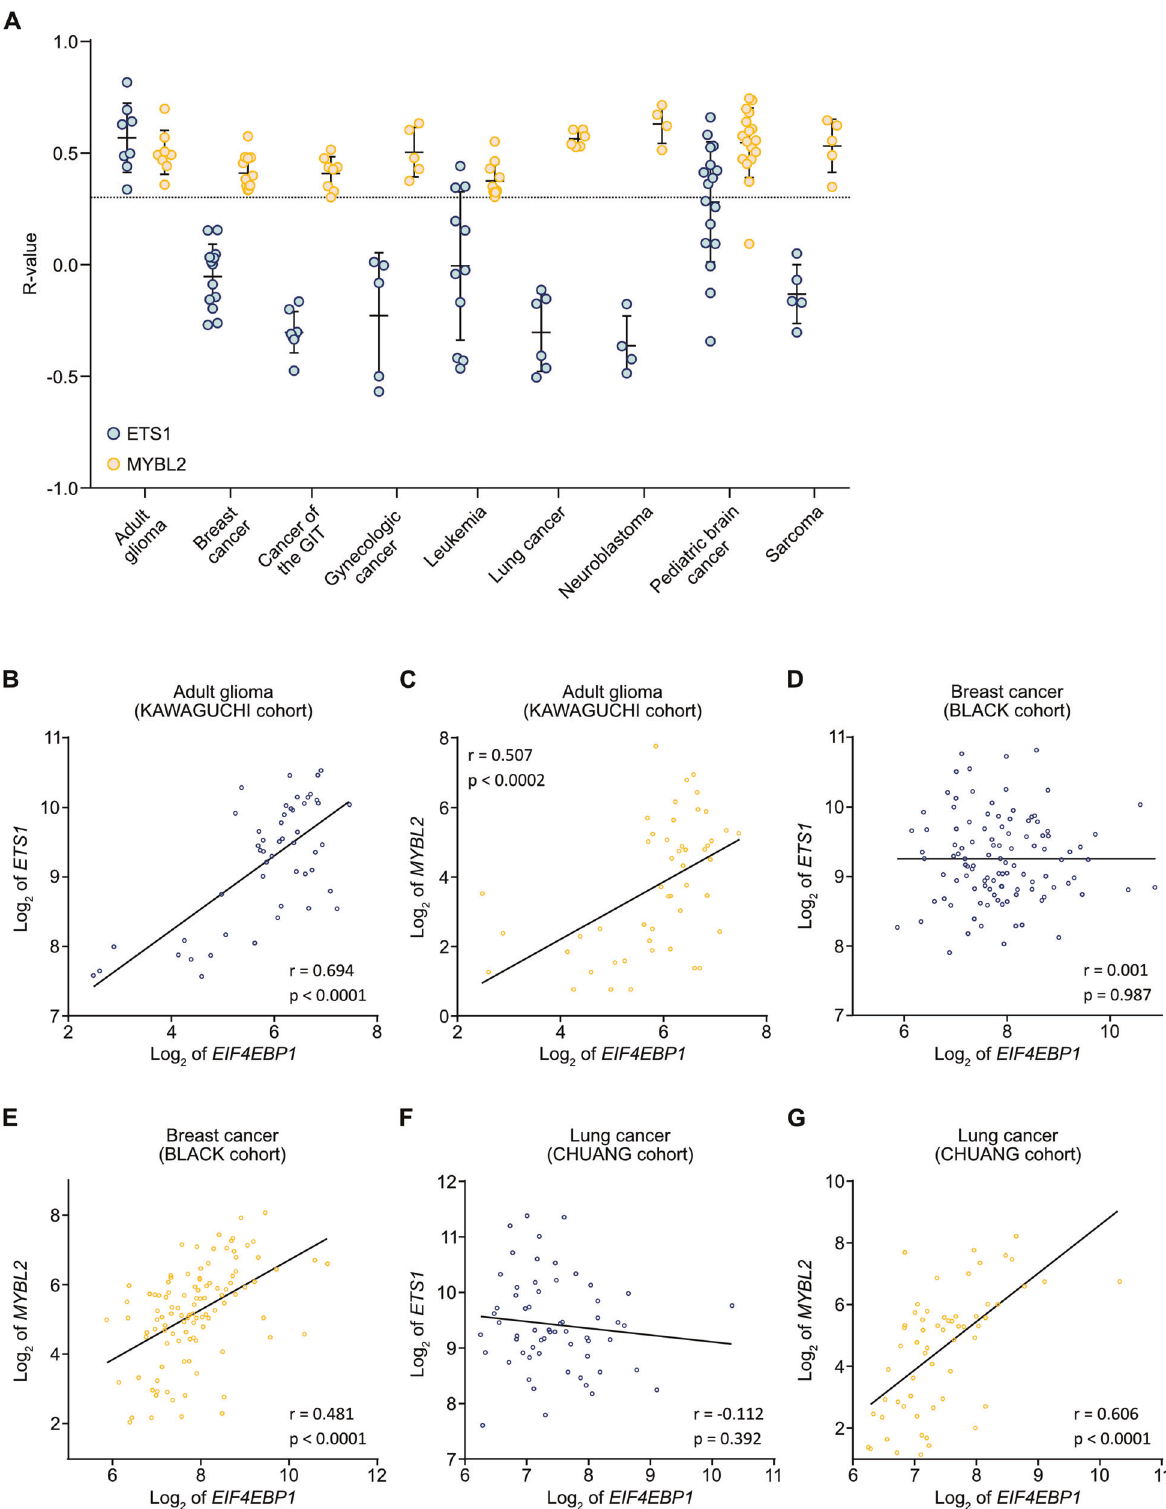
Fig. 5 Co-expression of EIF4EBP1 and MYBL2 or ETS1 in different cancer entities. A Correlation between the mRNA expression levels of EIF4EBP1 and ETS1 (light blue dots) or MYBL2 (yellow dots) in the indicated human cancer types (Table S3). Co-expression levels were quanti fi ed by calculating the Pearson correlation coef fi cient. Each dot represents the R -value for one cohort. The dotted line corresponds to an R -value of 0.3, chosen as the cut-off for positive correlation. B – H Representative co-expression analysis between EIF4EBP1 mRNA and B , D , F ETS1 (light blue dots) or C , E , G MYBL2 (yellow dots) mRNA levels in the indicated tumor type and cohort. The represented cohorts are ( B , C ) glioma (KAWAGUCHI cohort; n = 50) [36], D , E breast cancer (BLACK cohort; n = 107) [45], and F , G lung cancer (CHUANG cohort; n = 60) cohort [46]. Co-expression levels were quanti fi ed by calculating the Pearson correlation coef fi cient. GIT, gastrointestinal tract.